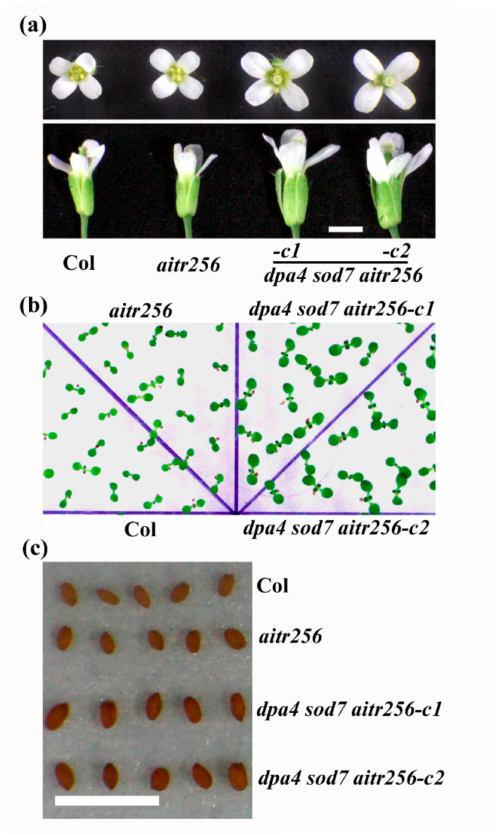
Figure 2. Organ and seed size in the dpa4 sod7 aitr256 quintuple mutants. ( a ) Flowers of the Col wild type, the aitr256 triple and the dpa4 sod7 aitr256 quintuple mutants. Pictures were taken from the third flower on the main inflorescence stem of the plants indicated. ( b ) Seedlings of the Col wild type, the aitr256 triple and the dpa4 sod7 aitr256 quintuple mutants. Seeds were sterilized and then plated on 1 / 2 MS plates. The plates were kept at 4 ◦ C in darkness for 2 days before transferred to a growth room. Picture was taken 5 days after the transfer. ( c ) Seeds of the Col wild type, the aitr256 triple and the dpa4 sod7 aitr256 quintuple mutants. Picture of dry seeds was taken for the plants indicated. Bar, 0.2 cm. 2.2. The dpa4 sod7 aitr256 Quintuple Mutants are Hyposensitive to ABA and